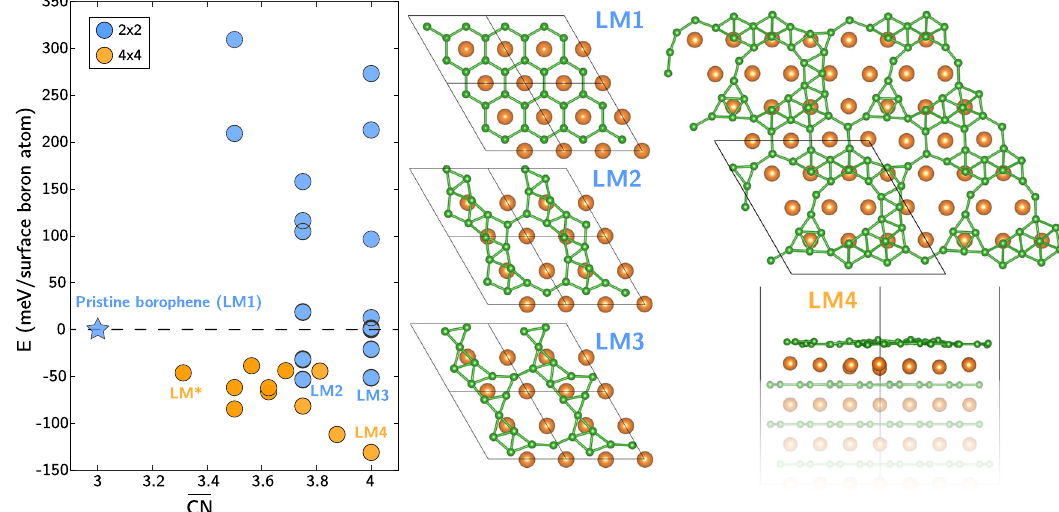
Fig. 1 Reconstruction of surface boron sheets. Energies of 2 × 2 (blue) and 4 × 4 (orange) slabs with different locally stable surface boron patterns found during the structure search, referenced to the pristine hexagonal borophene structure (blue star) and plotted against the average surface B − B coordination number. Select surface structures of interest are labeled, with corresponding structures shown at right (see Fig. 7 for LM* structure). The globally optimized LM4 structure is shown in top and side views at far right. Atom color codes: green: B, orange: